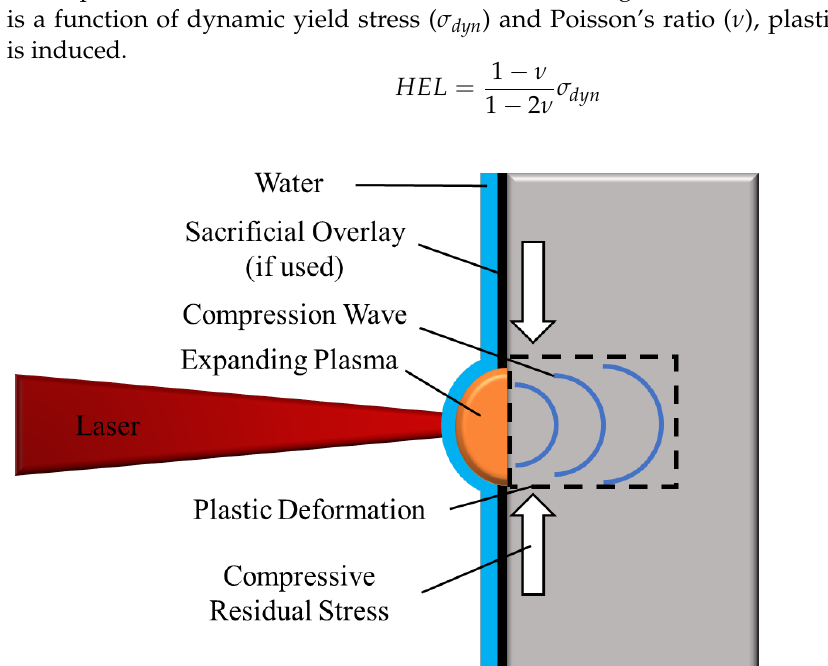
Figure 1. Schematic of the LP Process illustrating the interactions between the expanding plasma and the workpiece as well as the locations of the confining and sacrificial overlays. The outward expanding plasma and corresponding material response (plastic deformation and residual compressive stresses) are also shown.